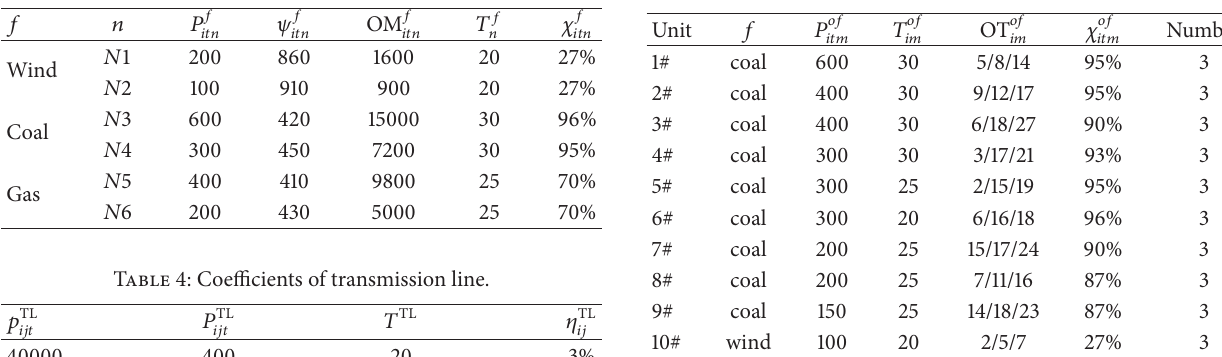
Table 3: Coefficients of alternative units.